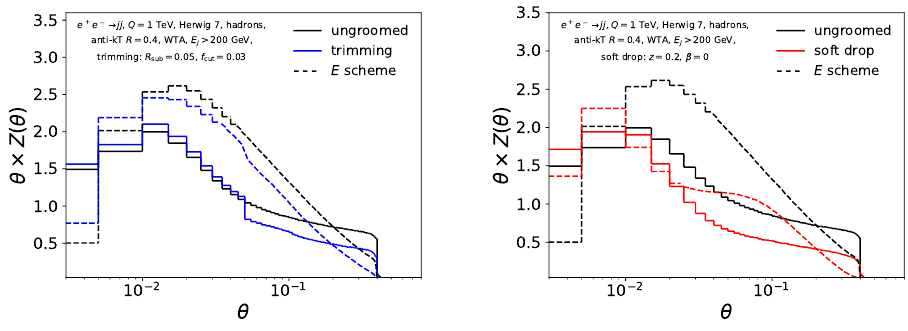
Figure 13 . The jet shape with respect to the WTA axis (solid) and standard jet axis (dashed) at hadron level. Left panel: after applying trimming (blue). Right panel: after soft drop (red).